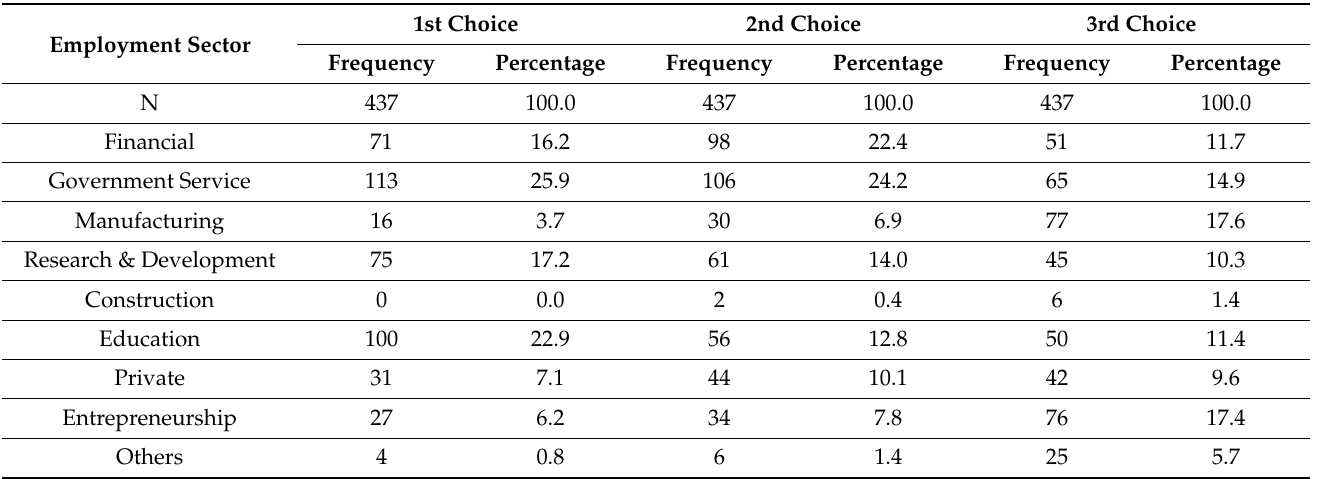
Table 9. Graduates Prioritization of Employment Sector.